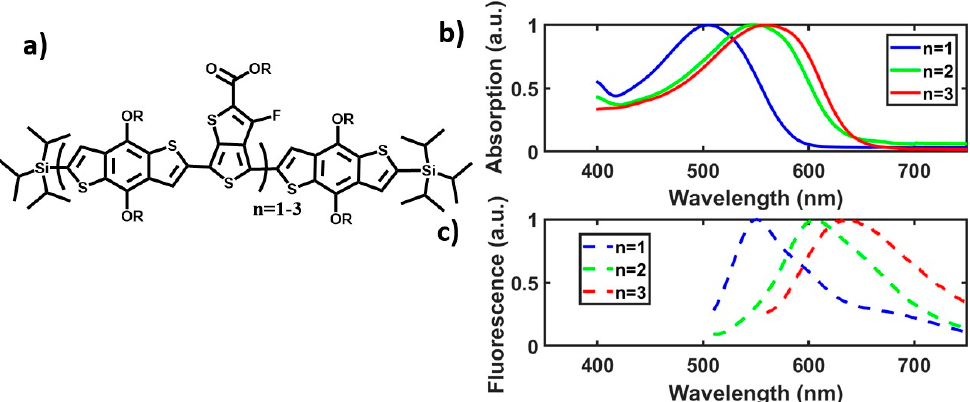
Figure 1. ( a ) Structure of (BDT-TT) n BDT PTB7 oligomer series. The R group is 2-ethylhexyl. Molecules are capped by TIPS (tri-isopropylsilyl) groups. ( b ) Normalized absorption spectra of n = 1–3 PTB7 oligomer series. The broad, featureless curves show a large shift between n = 1 and n = 2, but less of a shift between n = 2 and n = 3. ( c ) Normalized fluorescence spectra of n = 1–3 oligomers. The peak shift of the maxima does not exactly follow those in the absorption. There is some structure, with shoulders especially in n =